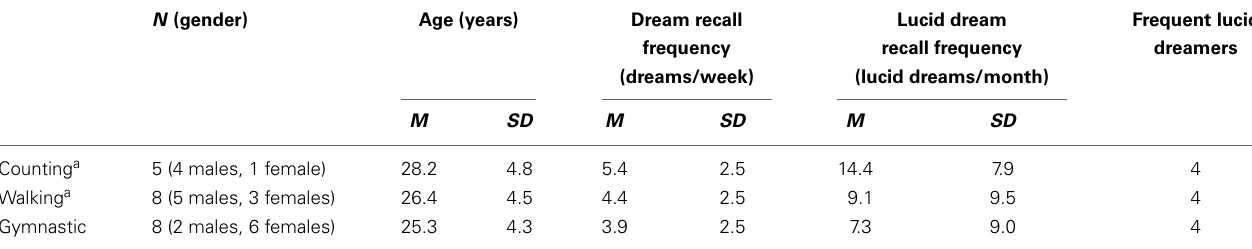
Table 1 | Participants characteristics.